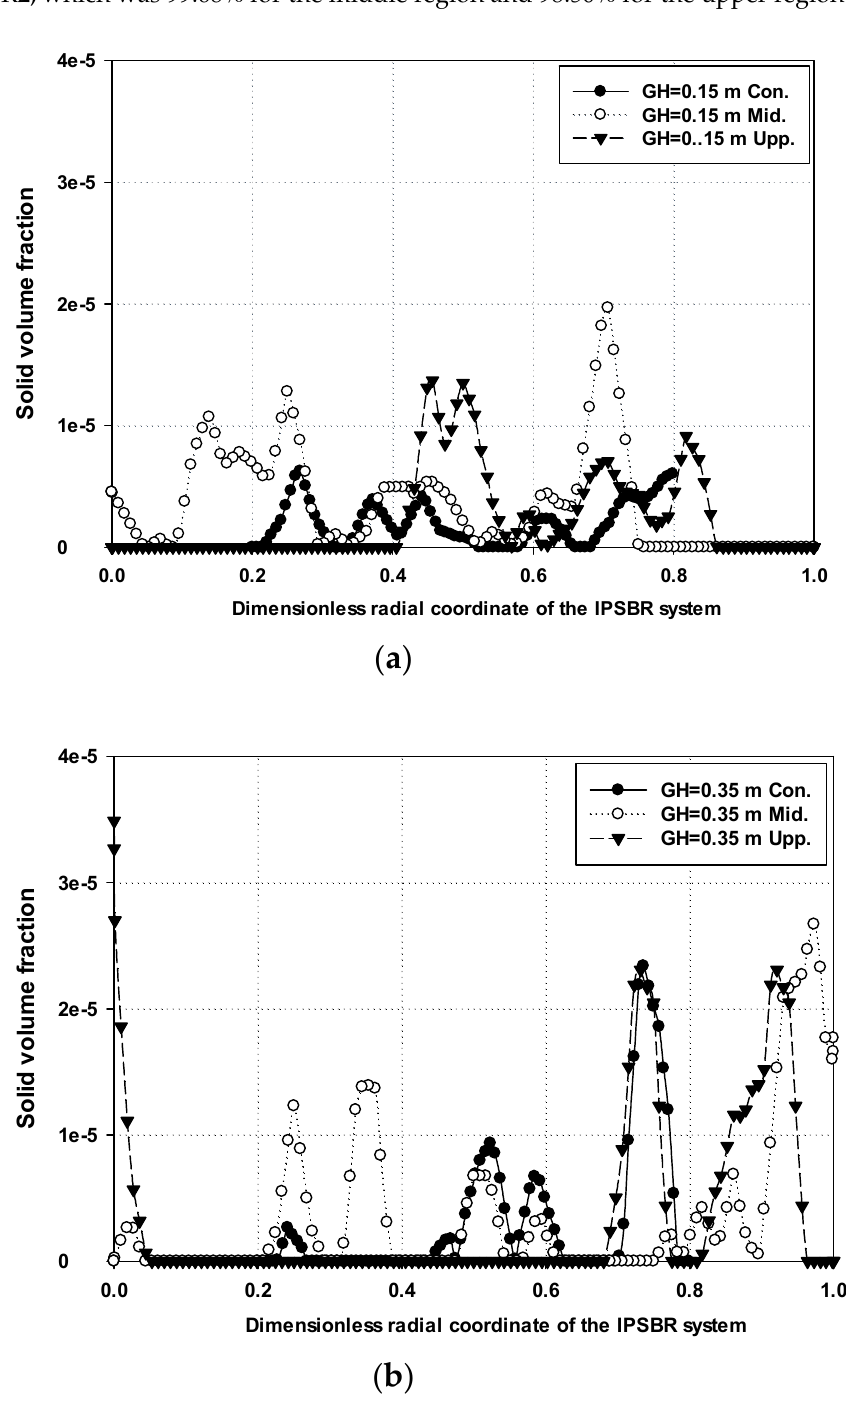
from 0.35 to 0.15, the solids concentration decreased throughout the reactor. The solid Table 3 and Table S1 show the results obtained from the regression model for the solid volume fraction at R = 0.55 m and a gas head of 0.15 m was around 1.2 × 10 − 6 in the upper mass concentration in the middle and upper regions, respectively. The p -values were low (<0.05) for most of the interactions, which is an indication of the high significance of the region. For a gas head of 0.35 at the same position (R = 0.55) m, the solid volume fraction model as reported by others [38–40]. Moreover, the regression model had a high value of approached the value of 2.3 × 10 − 6 in the upper region. R2, which was 99.68% for the middle region and 98.50% for the upper region.